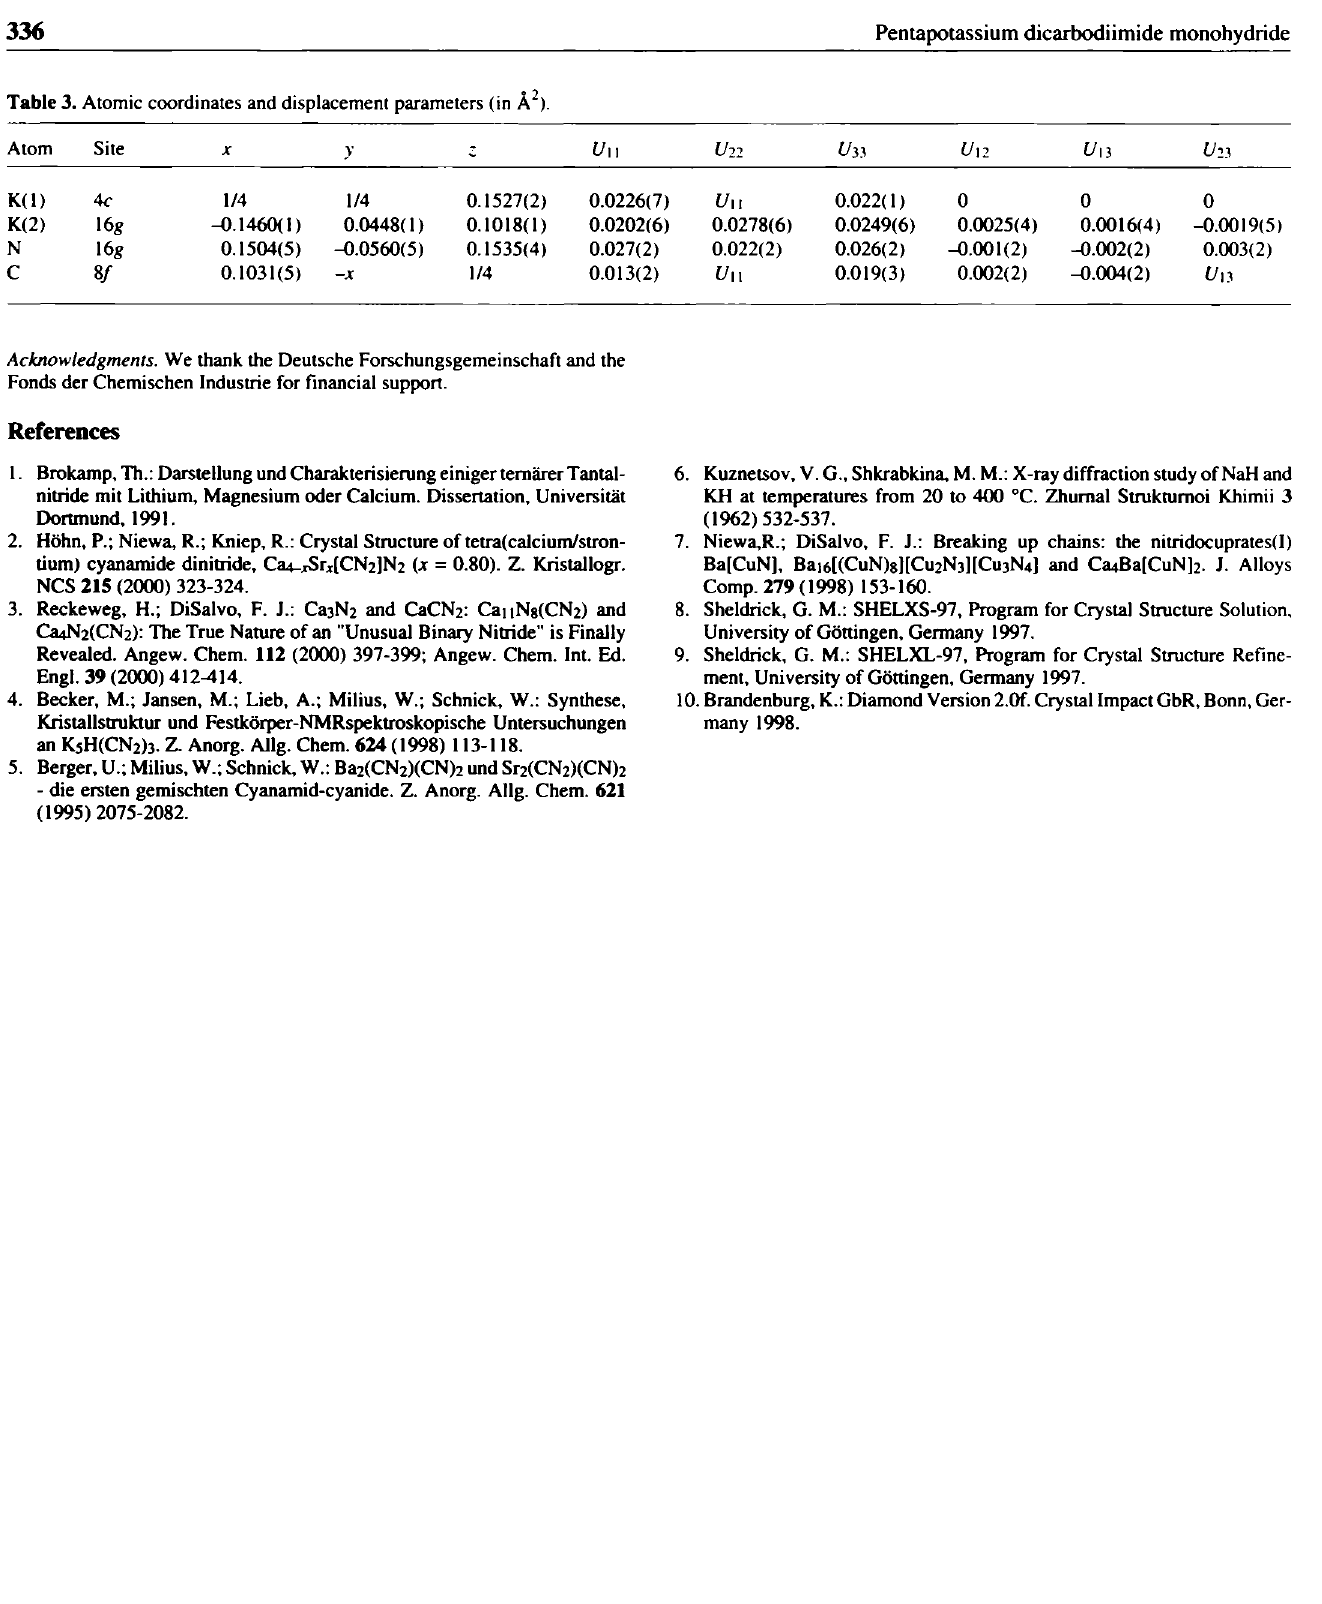
Table 3. Atomic coordinates and displacement parameters (in Ä 2